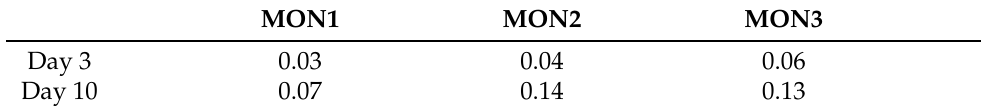
Figure 9. Comparison of mass and volume losses. Table 3. Increase in the air-filled microporosity volume fraction ( ∆ θ microporosity